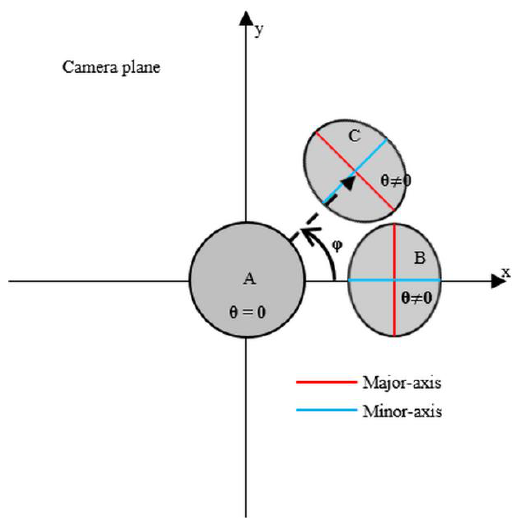
Figure 3. S hape of PPC according to ф and θ. Figure 3. Shape of PPC according to φ and θ